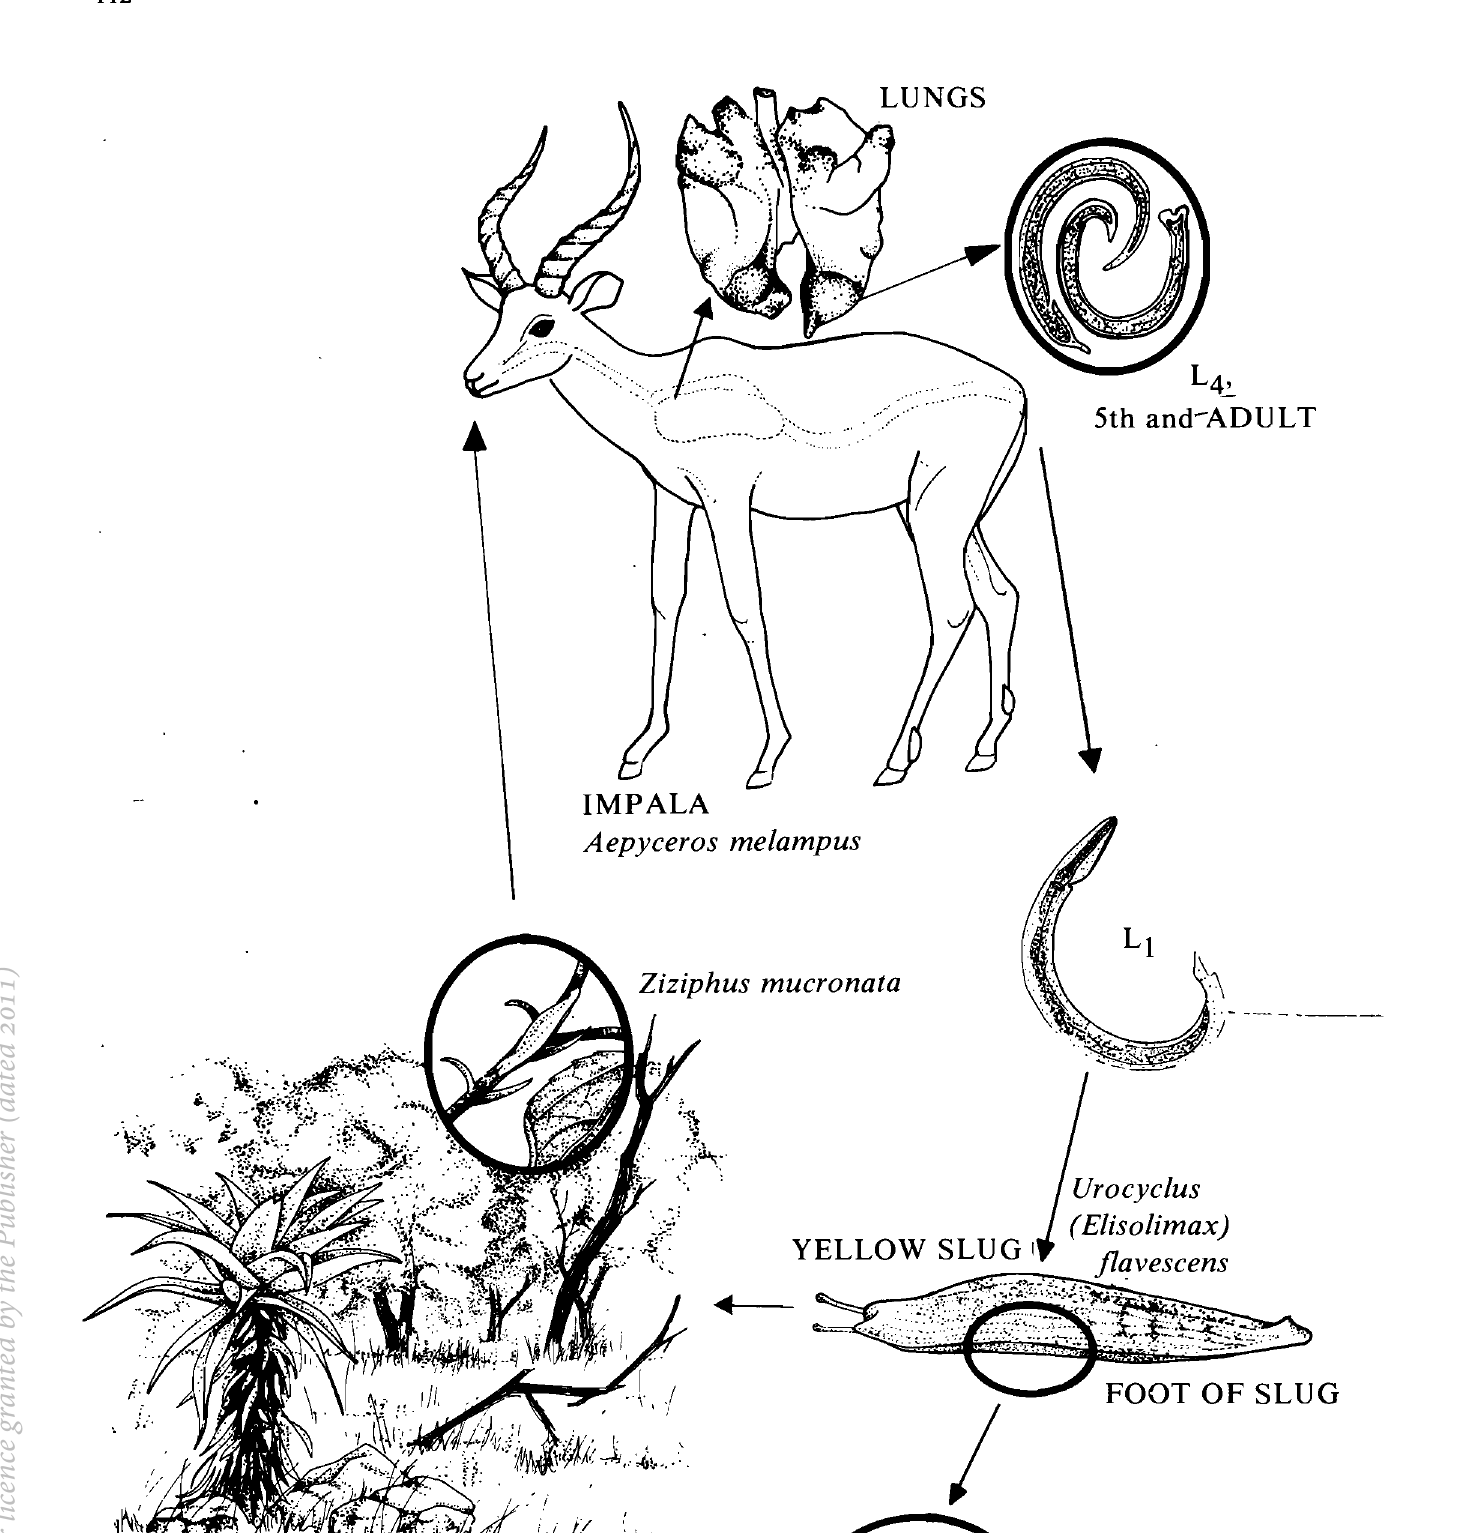
Fig. 2: Life cycle of Pneumostrongylus